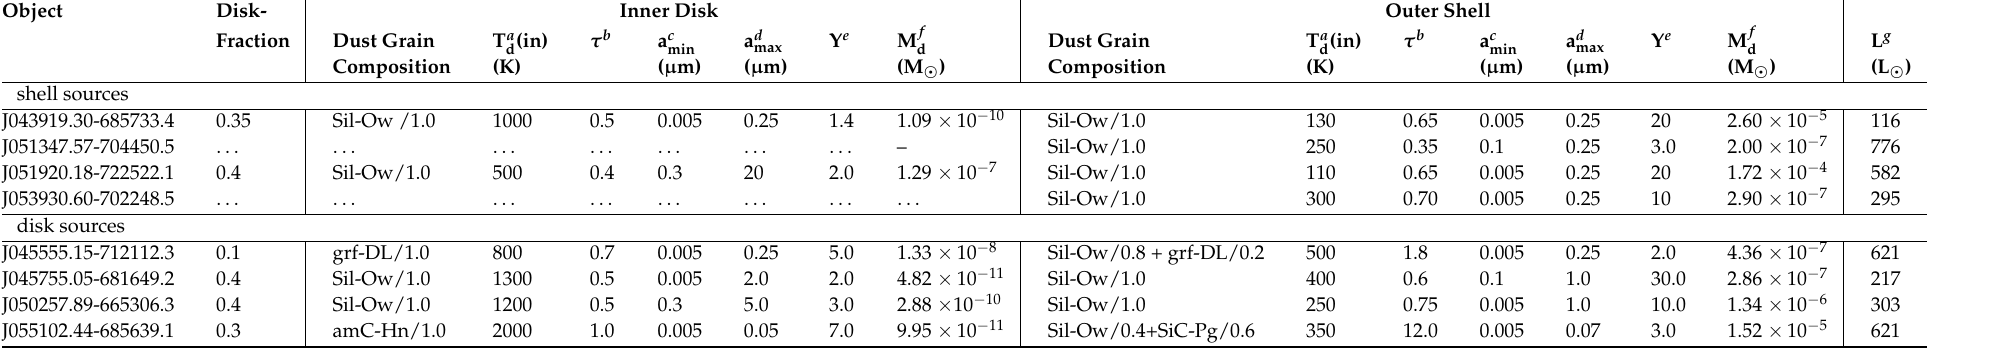
Table 1. Important parameters derived from the best–fit post-RGB models.